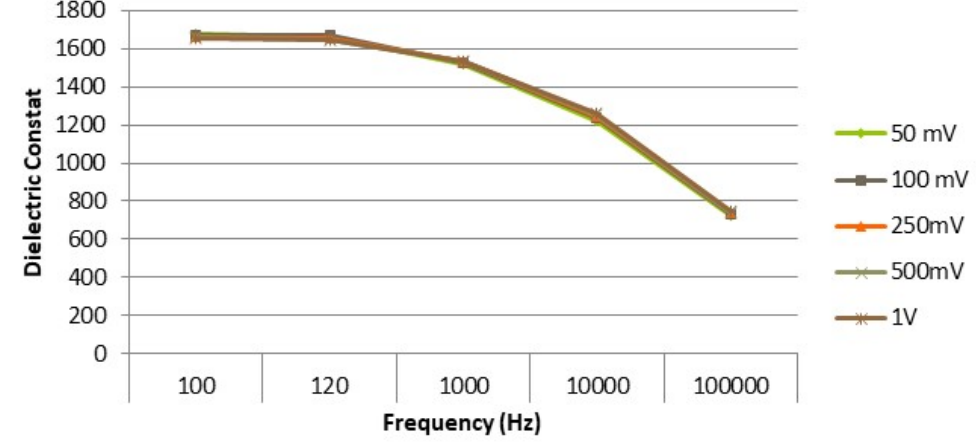
Figure 3. Dielectric constant of the S ‐ ZnSe crystal as a function of frequency at different biases. A tunability was observed as a function of frequency.